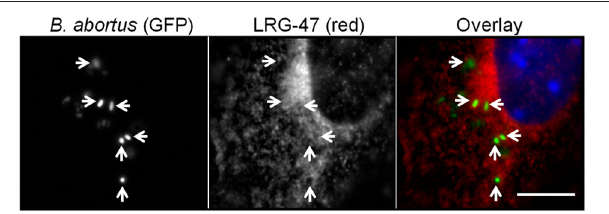
FIGURE 1 | B. abortus containing phagosomes adjacent to membranes containing the IFN- γ inducible protein LRG-47. Monolayers of RAW264.7 cells were stimulated with IFN- γ , infected with opsonized- B. abortus 2308 fixed 18h p.i. and stained to visualize the spatial relationship of the LRG-47 with the host cell (red). Brucella were observed in phagosomes adjacent to membranes positive for LRG-47 (arrow heads). Panel of images shown are representative of results from three separate experiments (bar = 5 μ